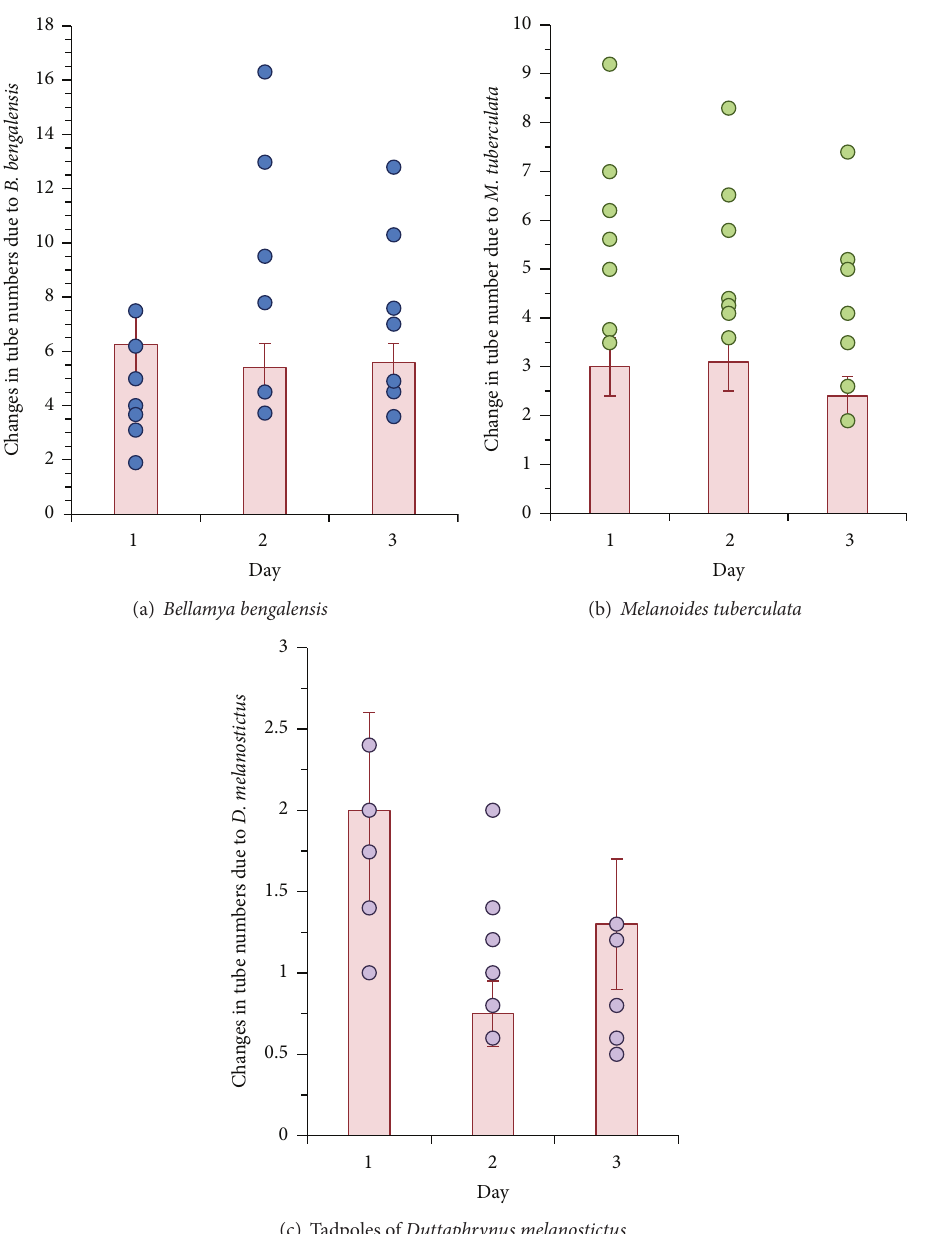
Figure 3: Changes in the tube numbers of the developing chironomid larvae in the quadrats due to the activity of snails and tadpoles (closed circles) and control (without non-predators, bar)